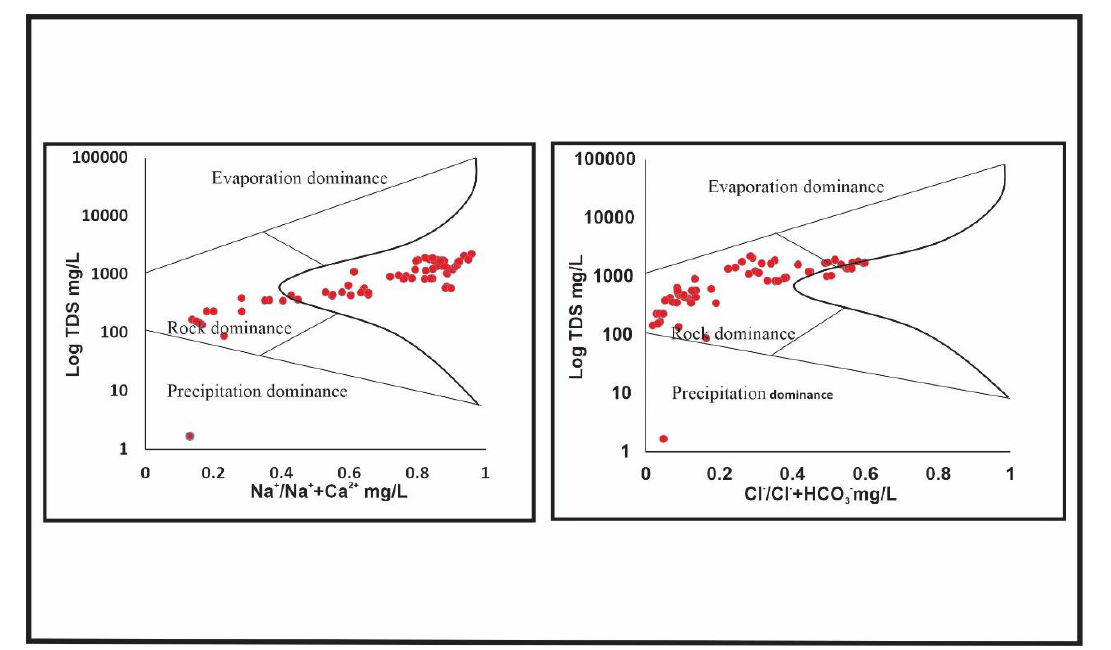
Figure 6. Gibbs plot depicting the composition of ions in the groundwater samples.